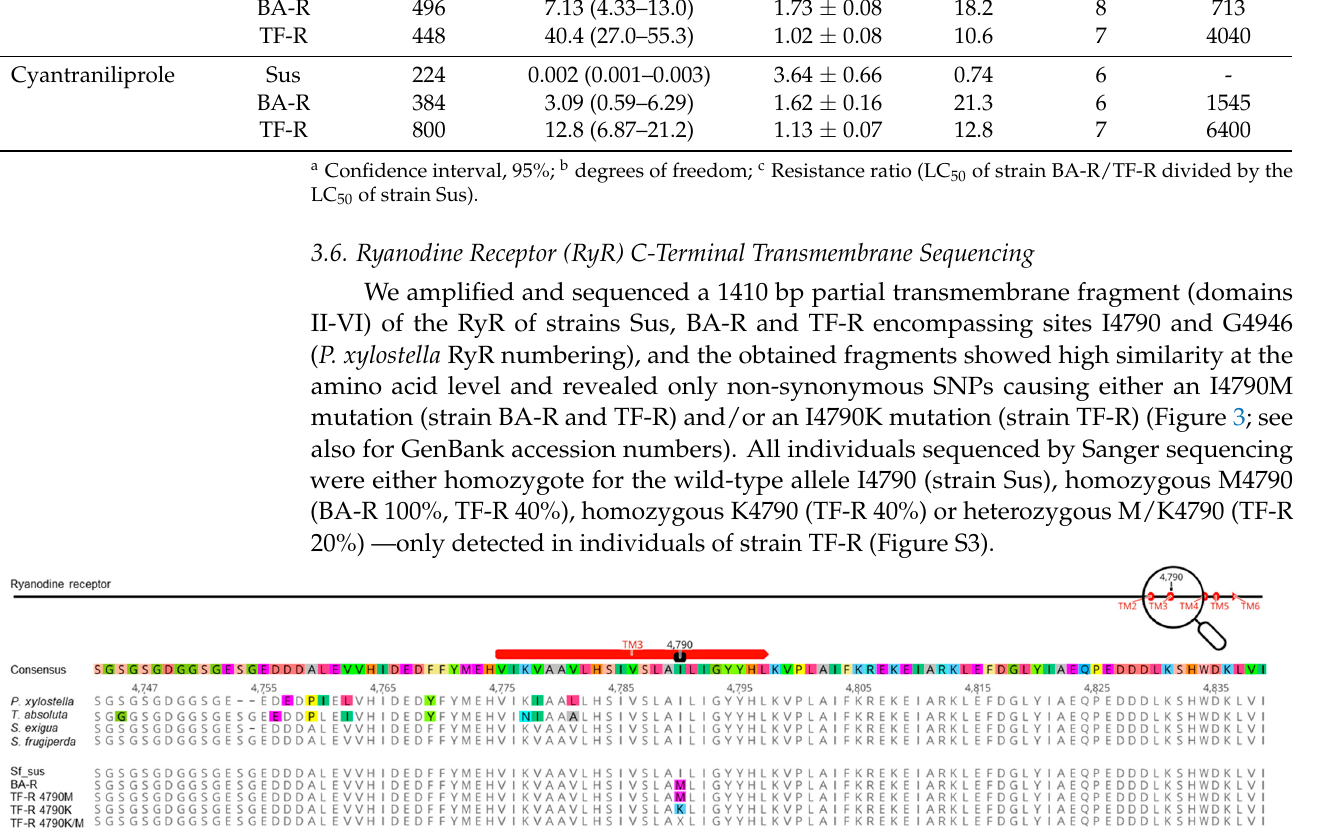
Table 4. Log-dose probit-mortality data for anthranilic diamide insecticides tested against larvae of different strains of Spodoptera frugiperda .